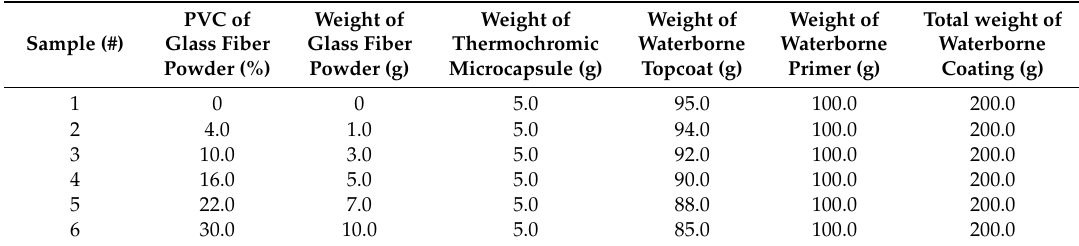
Table 1. The composition of waterborne coating with thermochromic microcapsule and glass fiber